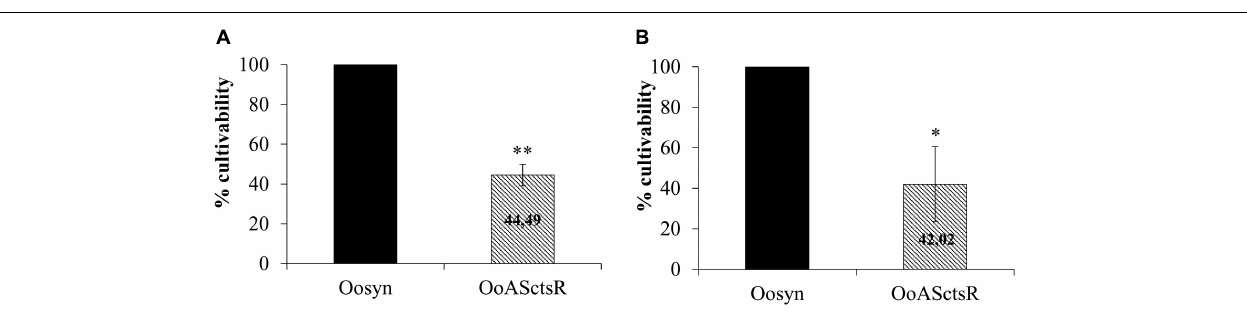
Frontiers in Microbiology |